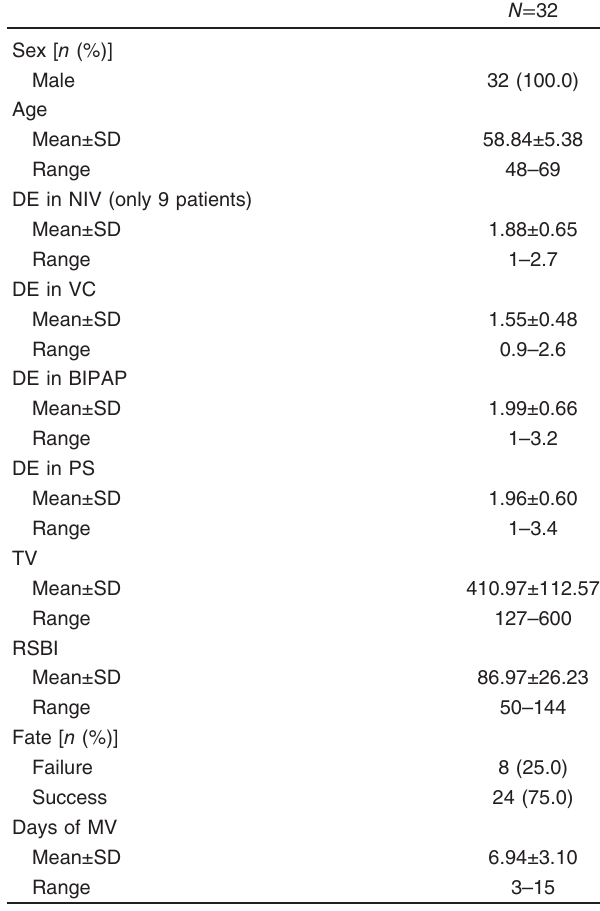
Table 1 Descriptive analysis for the studied